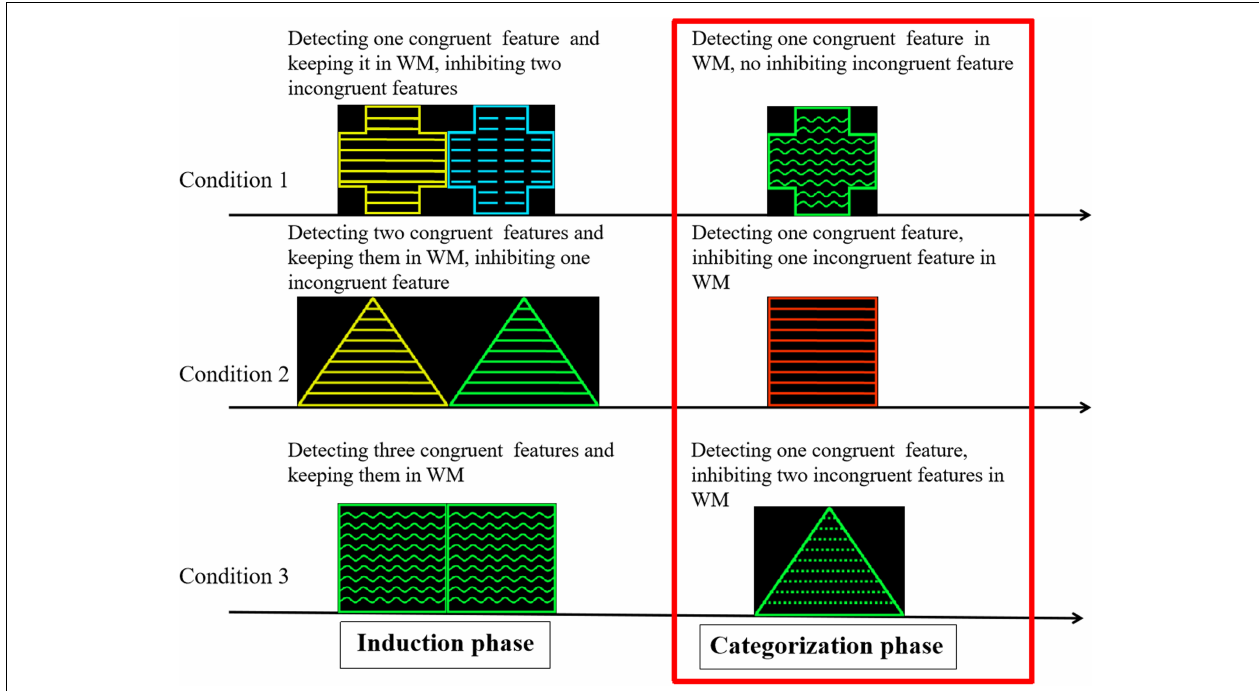
FIGURE 1 | Cognitive analysis in induction and categorization phase in category induction task. Stimuli samples were geometric figures that varied along three perceptual dimensions, with four attributes for each dimension: shape (triangle, square, round, and cross), color (yellow, blue, green, and red), and stripe direction (wavy, streaked, dotted, and straight